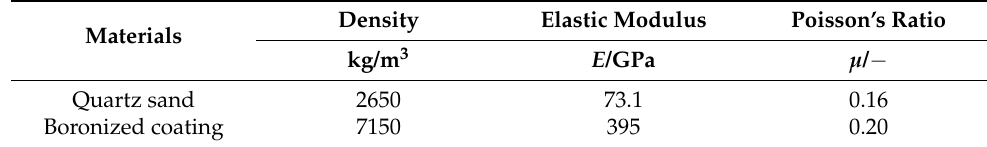
Table 1. Material parameters of the quartz sand particles and boronized